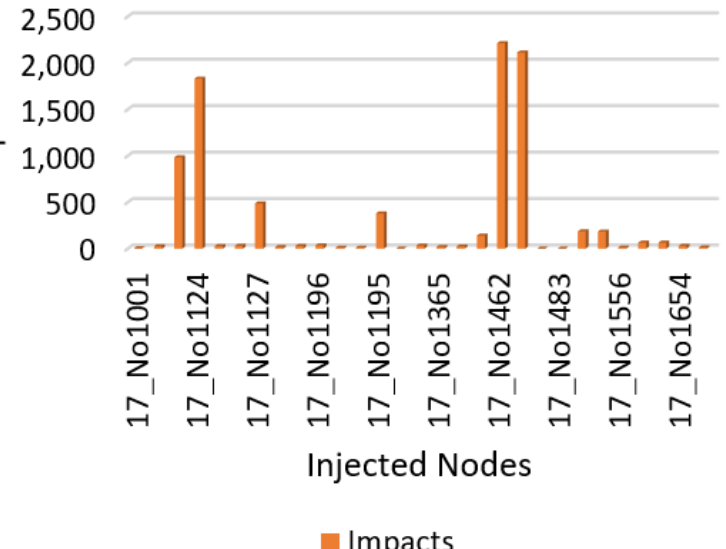
Figure 11. Health impact with 10 sensors deployed using volume of contaminated water (VCW). Table 5. Health impact with using 10 water quality sensors using time detection (TD). Injection Nodes In